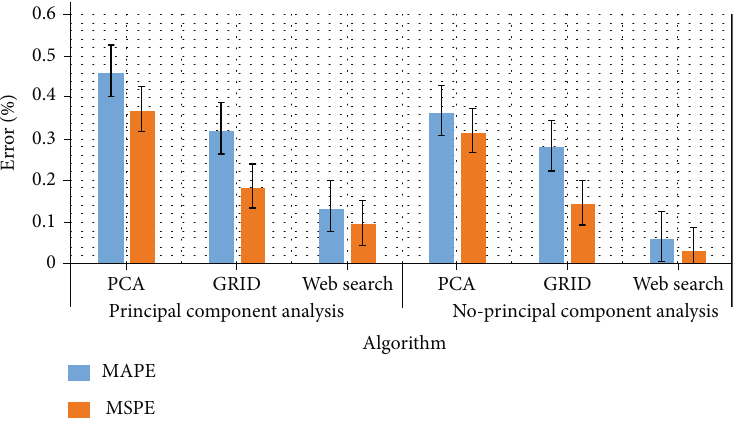
Figure 9: Analysis of application results of principal component